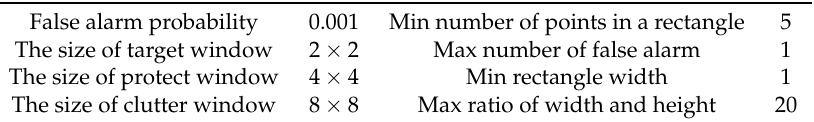
Table 3. Parameter setting of Experiment